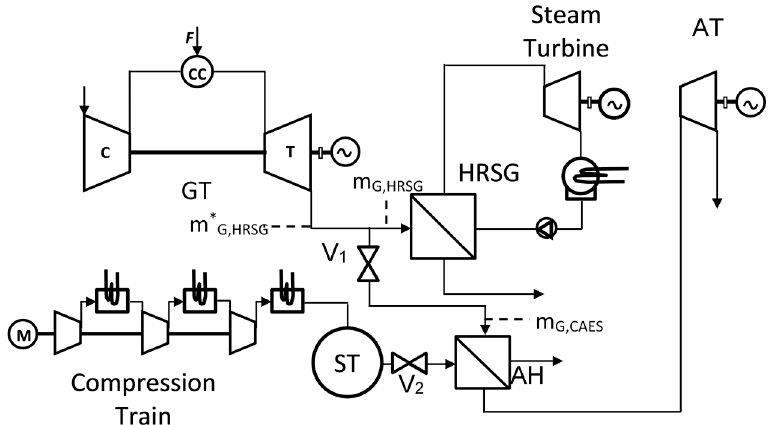
Figure 1. Reference plant scheme. Legend: GT: gas turbine; HRSG: heat recovery steam generator; M: electric motor; ST: storage tank; AH: air heater; AT: air turbine; (cid:1865) (cid:3008),(cid:3009)(cid:3019)(cid:3020)(cid:3008)∗ : gas mass flow rate entering the HRSG during gas–steam combined cycle (GSCC) normal operation; (cid:1865) (cid:3008),(cid:3009)(cid:3019)(cid:3020)(cid:3008) : gas mass flow rate entering the HRSG during the compressed air energy storage (CAES) discharge phase; (cid:1865) (cid:3008),(cid:3004)(cid:3002)(cid:3006)(cid:3020) : gas mass flow rate entering the AH during the CAES discharge phase.